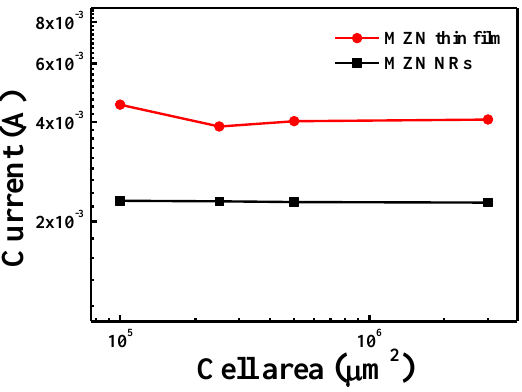
Figure 7. LRS currents versus cell areas of Al/MZN/ITO and Al/MZN NR/ITO devices.